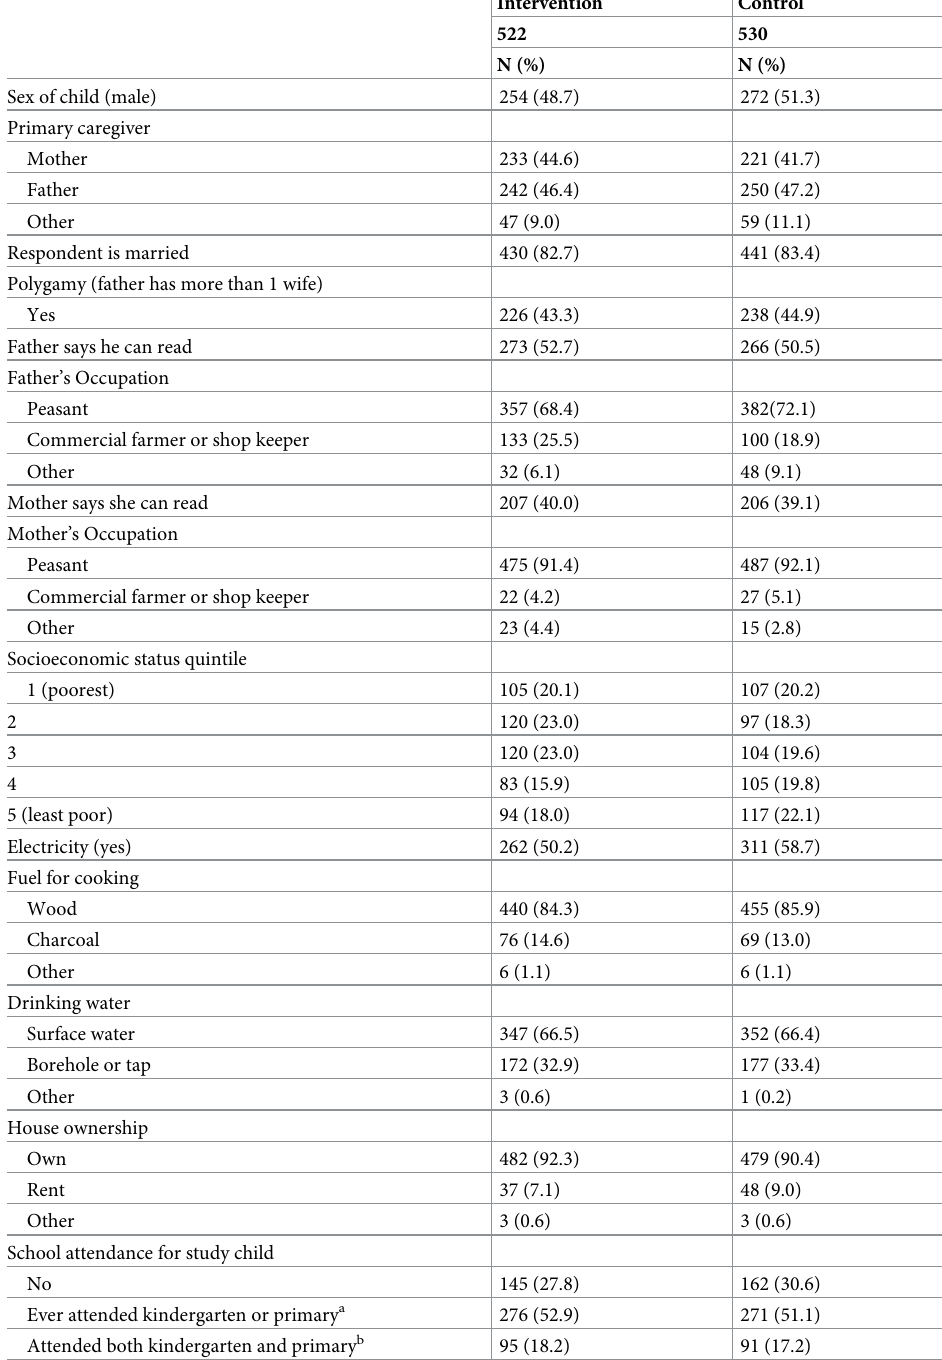
Table 2. Baseline characteristics, categorical variables